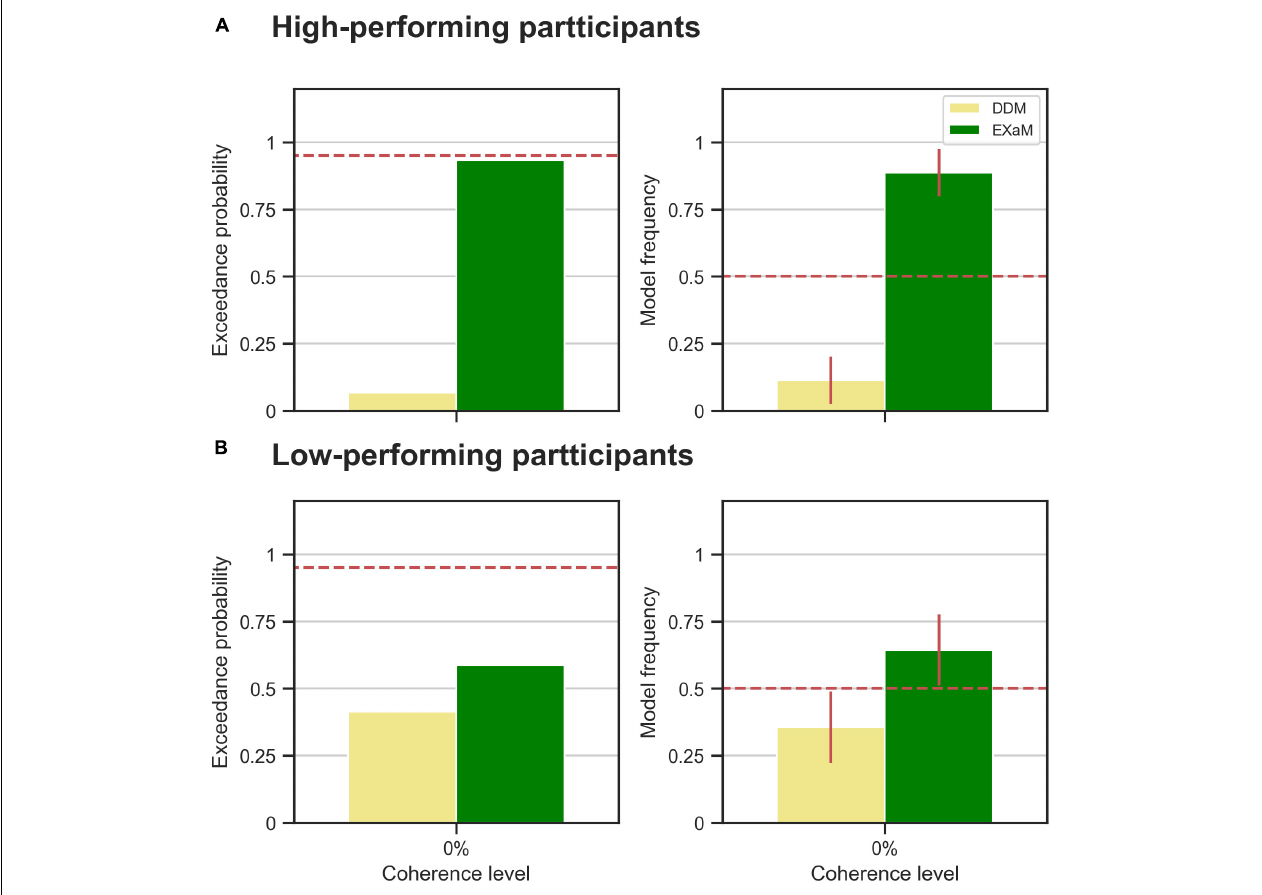
FIGURE 5 | Results of random-effects Bayesian model comparison for zero % coherence level across two groups of participants; (A) the observed model comparison results in Figure 4 are actually driven by the high-performing participants. The left plot shows the protected exceedance probability (probability that a model is the best model for all participants). The red dashed line indicates very strong evidence for a model (0.95). The right plot shows the model frequency for model comparison between DDM and EXaM. The model frequency is the probability that the behavior of a randomly selected participant is best explained by a specific model, among the compared models. The red dashed line represents chance level and error bars indicate the standard deviation of the estimated model frequencies. (B) The same plots as in A for the low-performing participants.